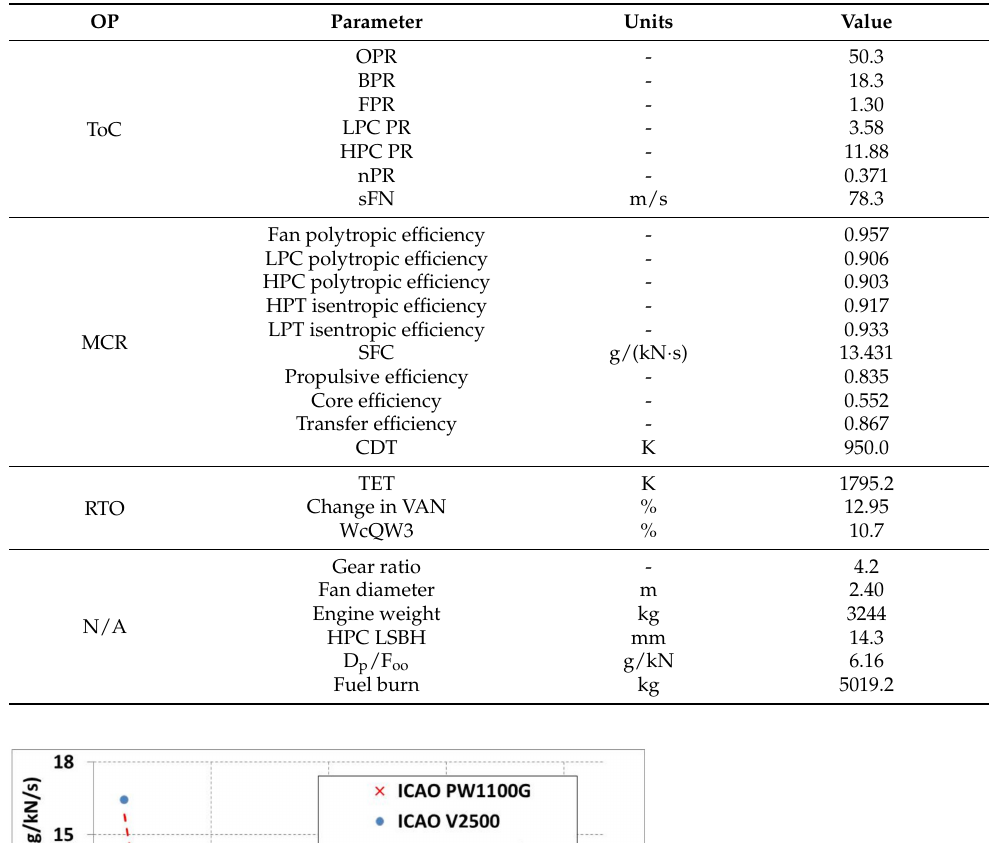
Table 3. Optimization results.